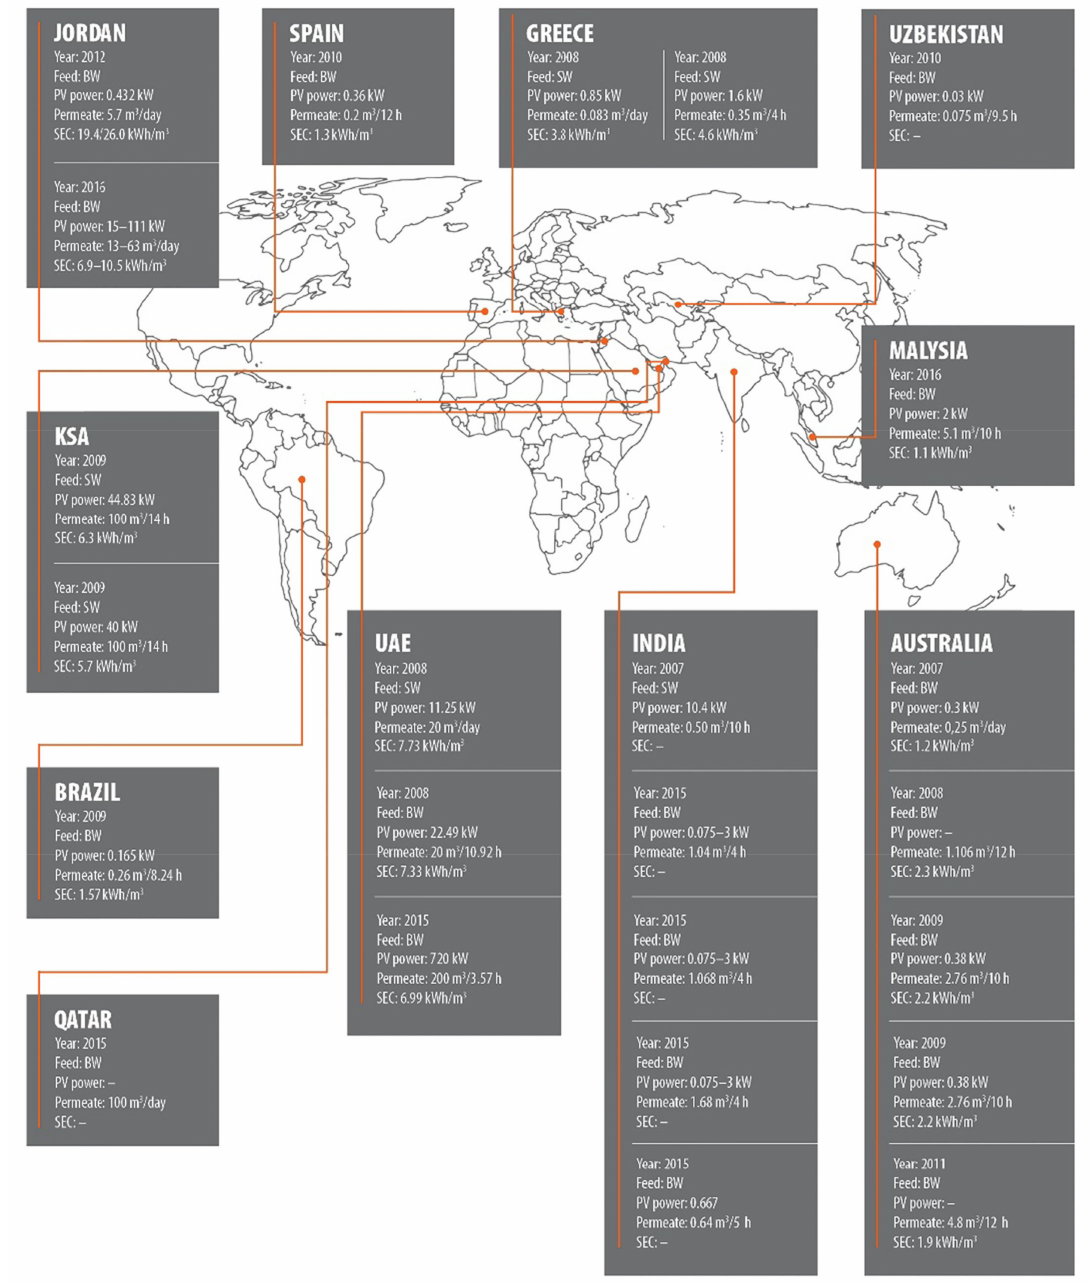
Figure 8. Some of the most important desalination plants powered by photovoltaic energy by region. Taken from